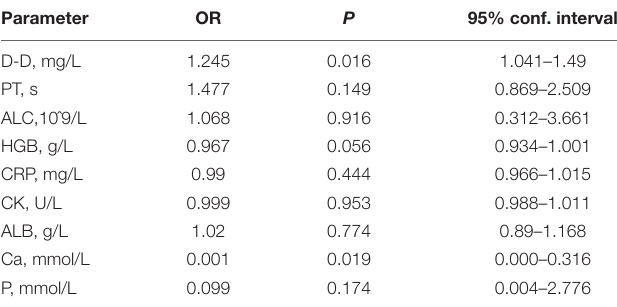
TABLE 5 | Multivariate Cox proportional hazard analyses of overall survival.